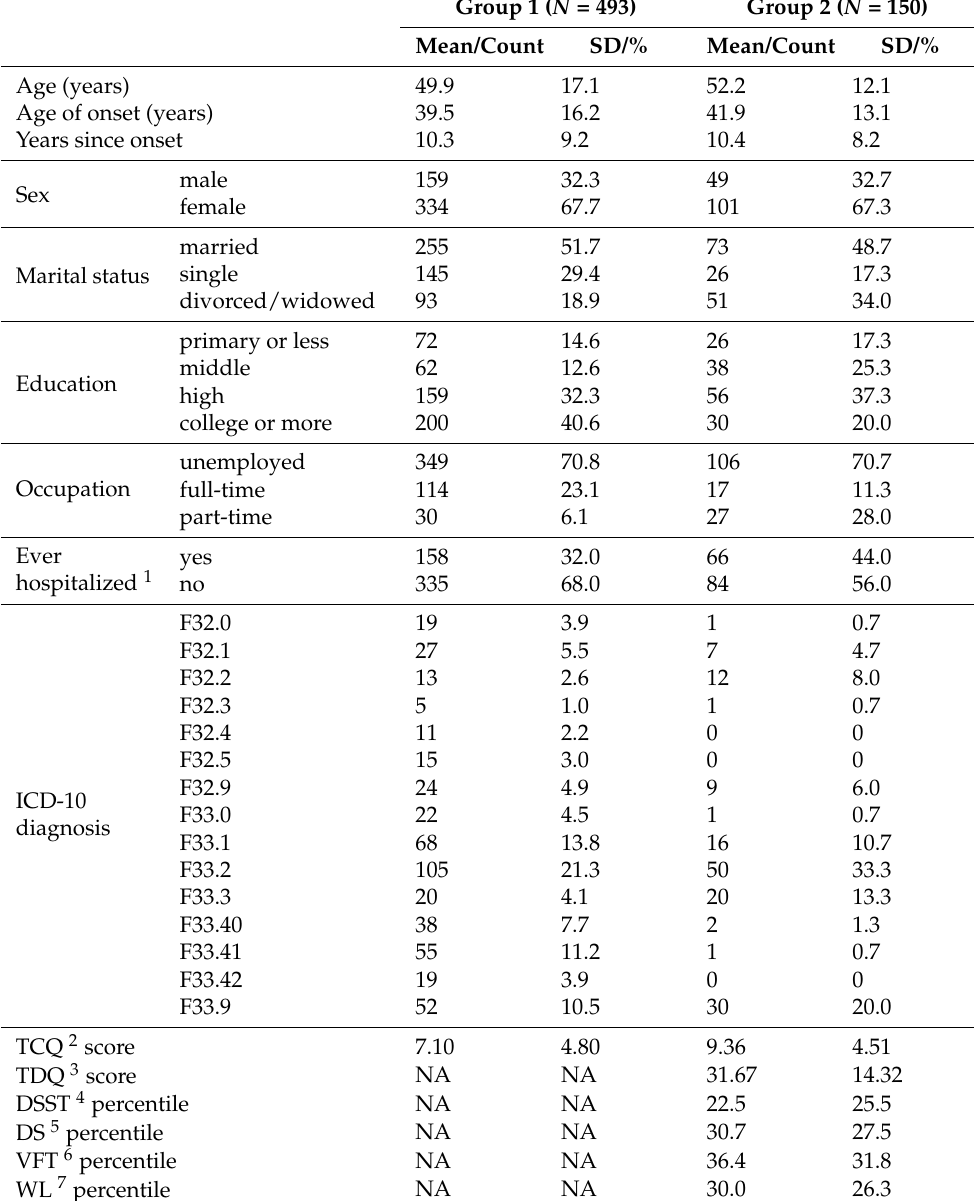
Table 2. Socio-demographics and characteristics of participants by group.